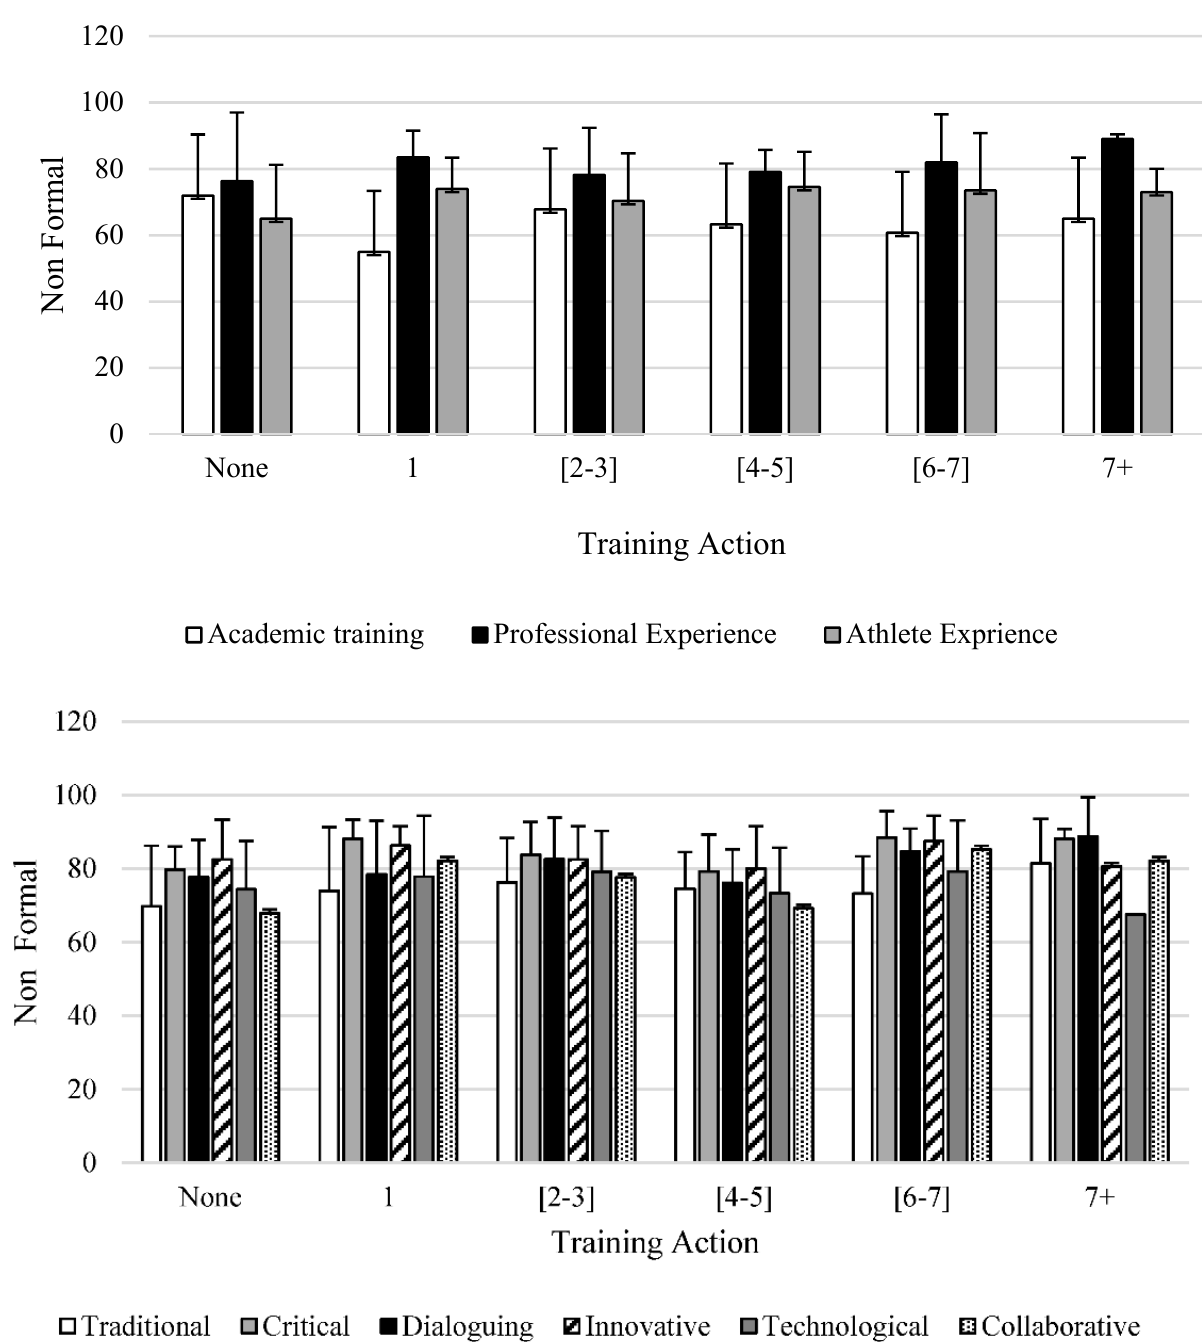
Figure 2. Descriptive statistics of the relationship between training and profile of SOPC and non-formal learning training. Figure 3 shows the relationships between the SOPC training and the SOPC profile. Initially, a bivariate analysis was carried out in order to determine the relationship between the variables. In this context, we used the Pearson coefficient to analyze the intensity between the training and coach profile variables and to determine the significance of the correlations between them. In the analysis of the results, only positive correlations were revealed, with two types of significance: weak positive and moderate positive